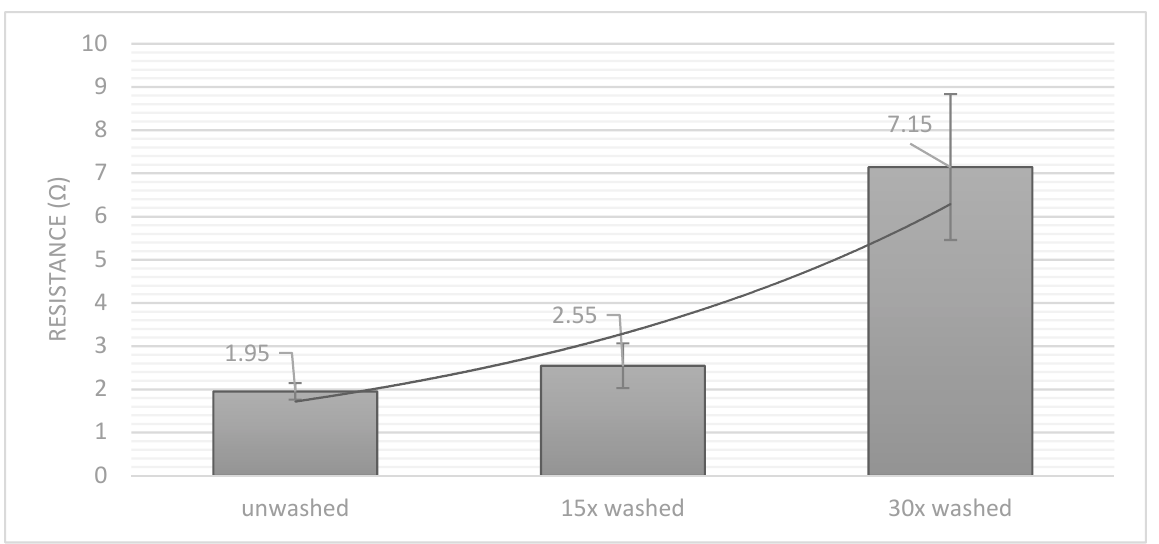
Figure 8. Contact resistance from the four-wire resistance test after different washing cycles (black exponential trend line).